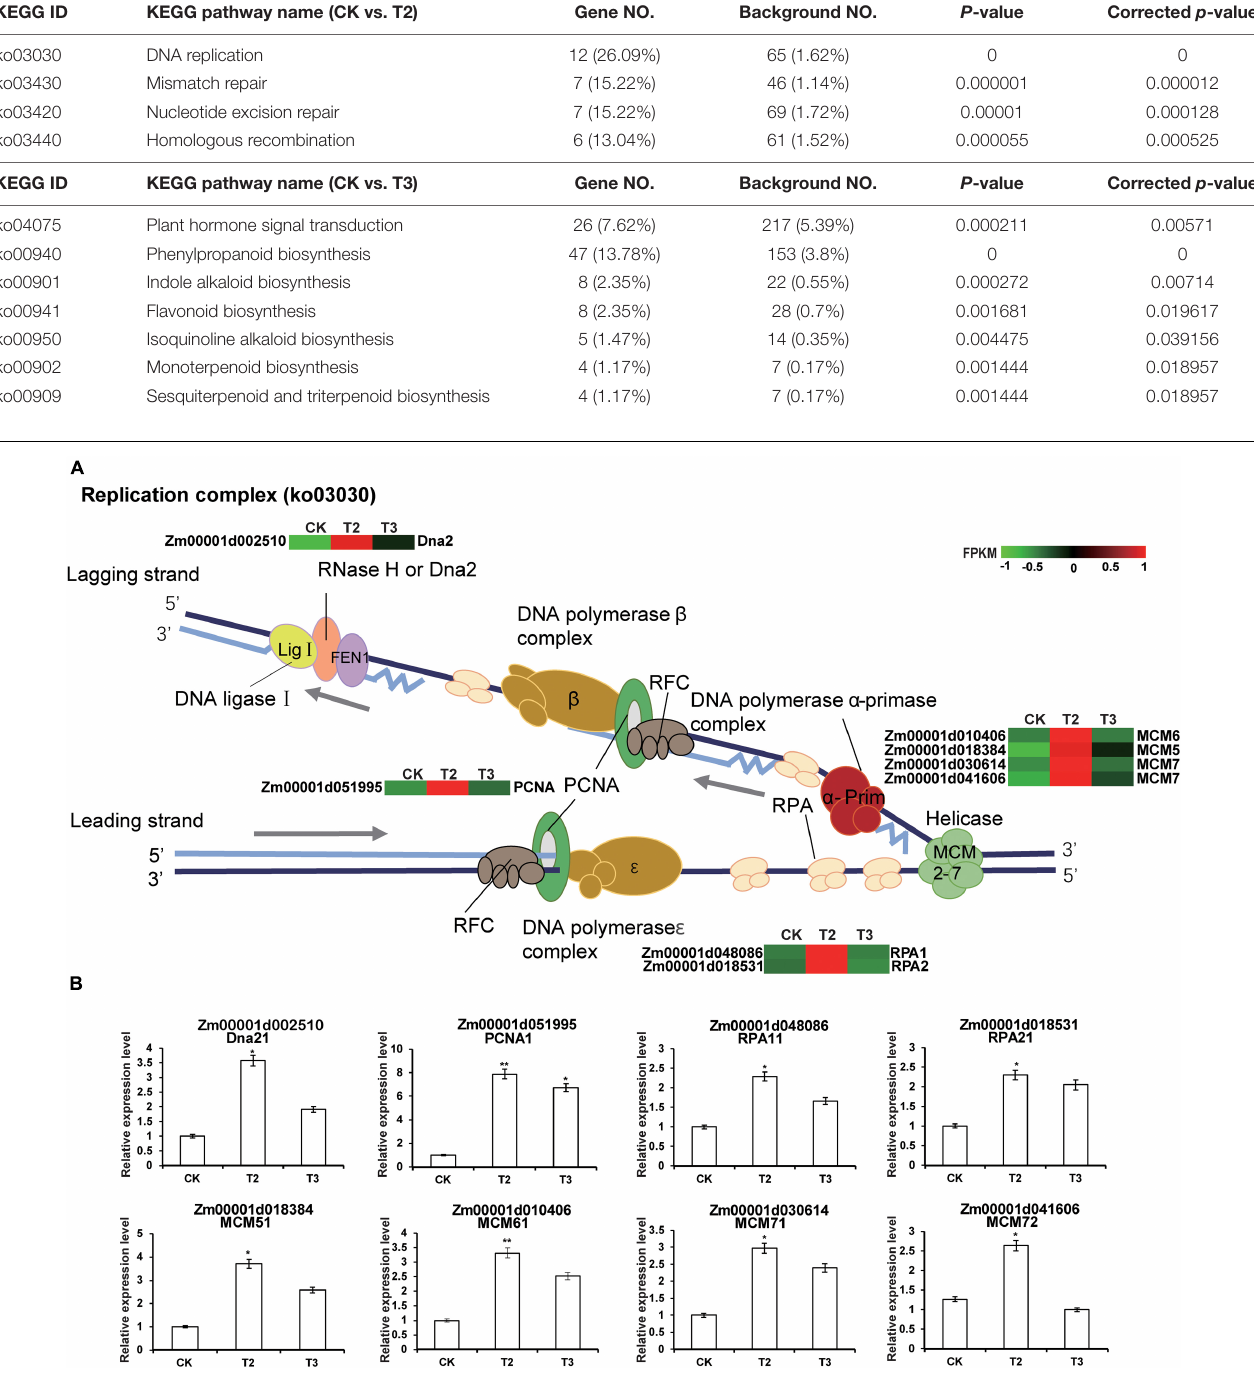
Frontiers in Plant Science |